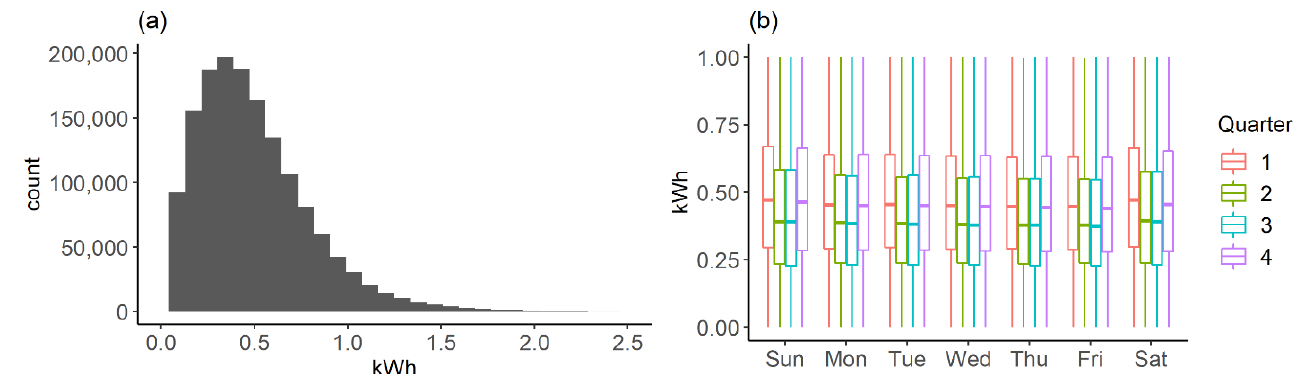
Figure 3. ( a ) Half-hourly daily mean average distribution. ( b ) Half-hourly daily mean average range by quarter and day of the week.